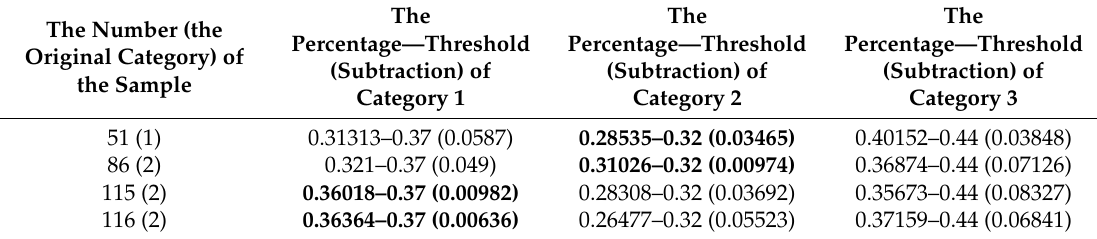
Table 2. The percentage and subtraction of each uncertain Haoyu21 corn seed